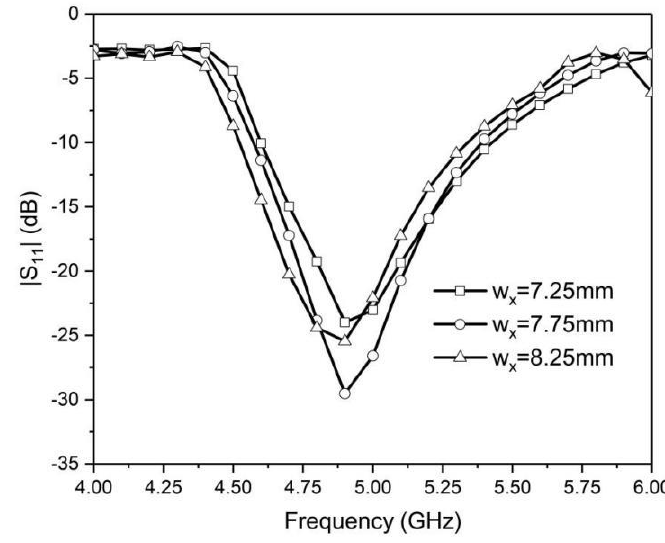
Figure 11. Simulated |S 11 | of the proposed array antenna with different mushroom cell sizes 𝑊 𝑥 .